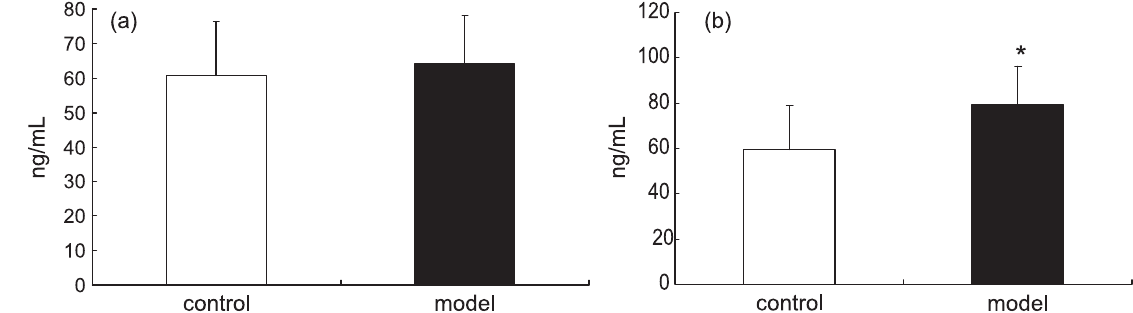
FIGURE 4 - Effects of hyperuricemia on IL-1β concentration in serum in different time. Data are mean ±SD, n =8. (a): in 2 nd week and (b): in 4 th week. * P<0.05 compared with control